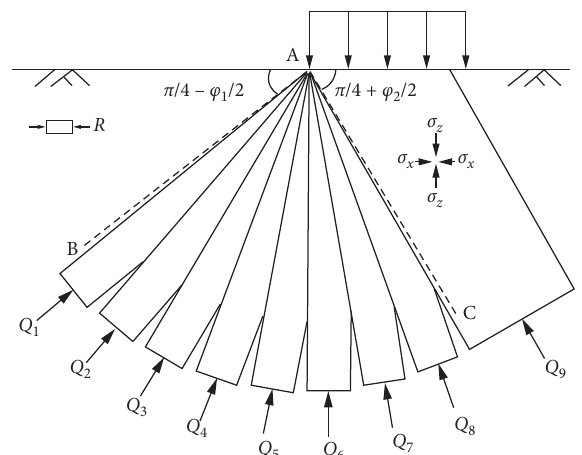
Figure 6: Stress field constructed by 9 stress